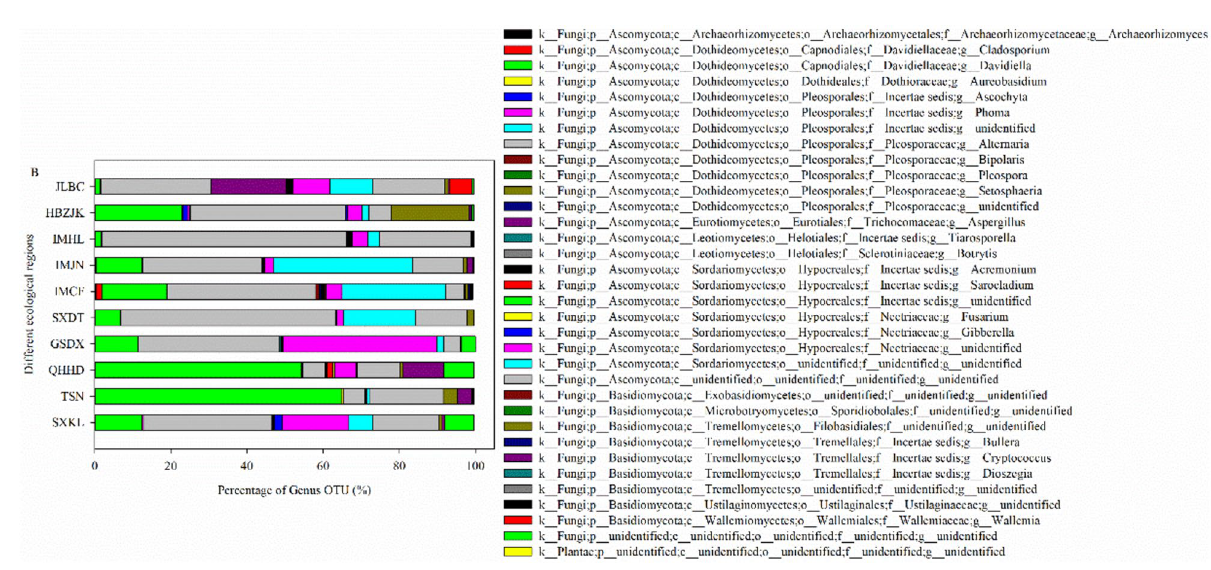
Figure 1. Genus-level taxonomic composition of fungal pathogens on grain surfaces of Bayou 13 from 10 ecological regions. SXKL, TSN, QHHD, SXDT, GSDX, IMCF, IMJN, IMHL, HBZJK, and JLBC indicate